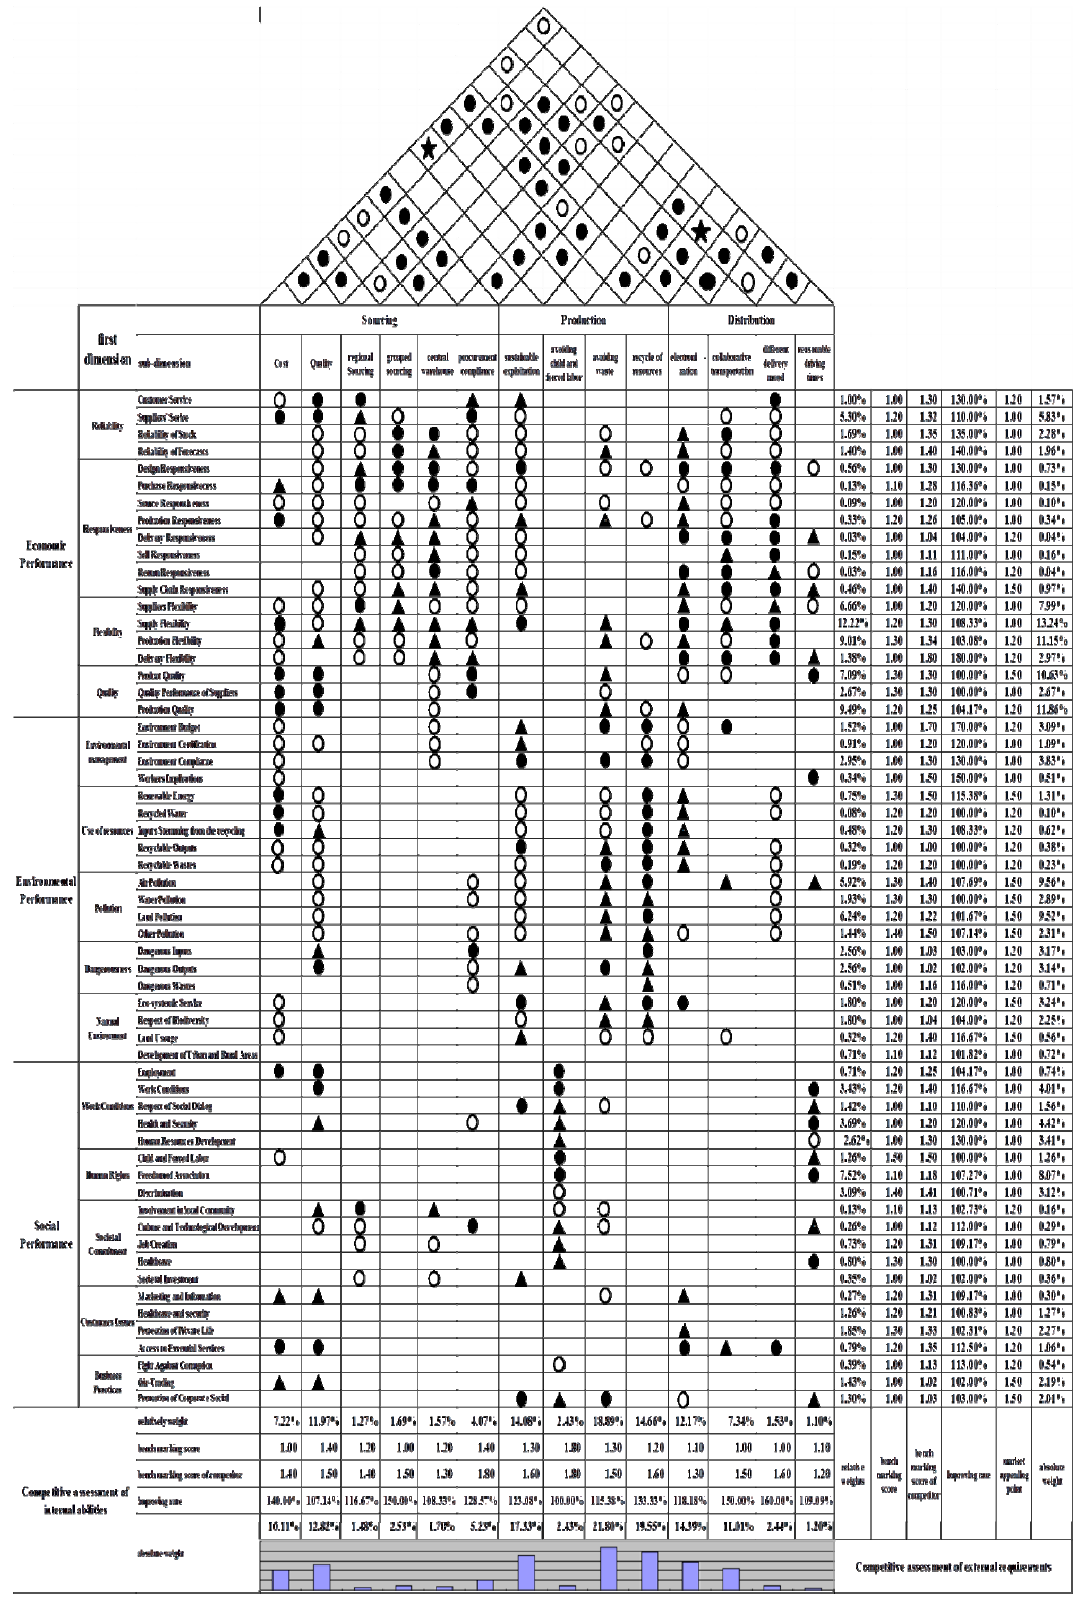
Figure 1. House of quality.